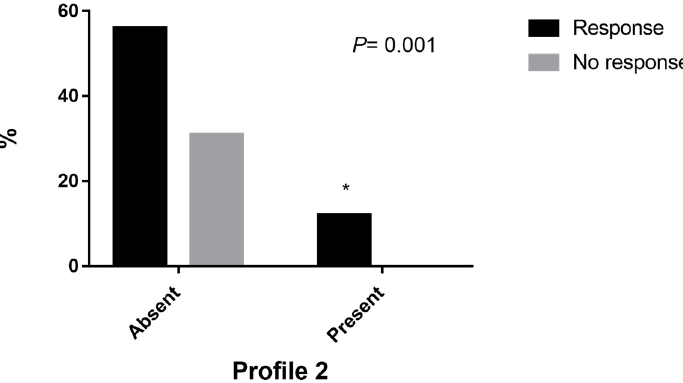
Figure 1. Frequencies based on the response to treatment of profile 2. * ( p = 0.001)